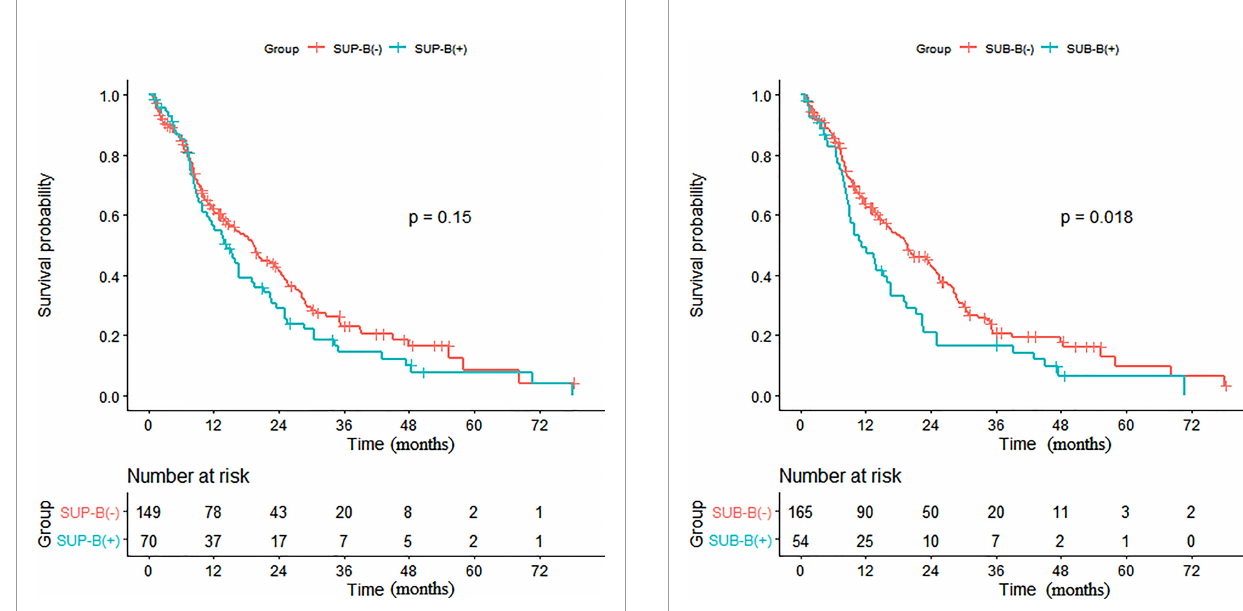
FIGURE 3 | Kaplan-Meier survival analysis of patients with and without SUB- B. (SUB-B, subphrenic